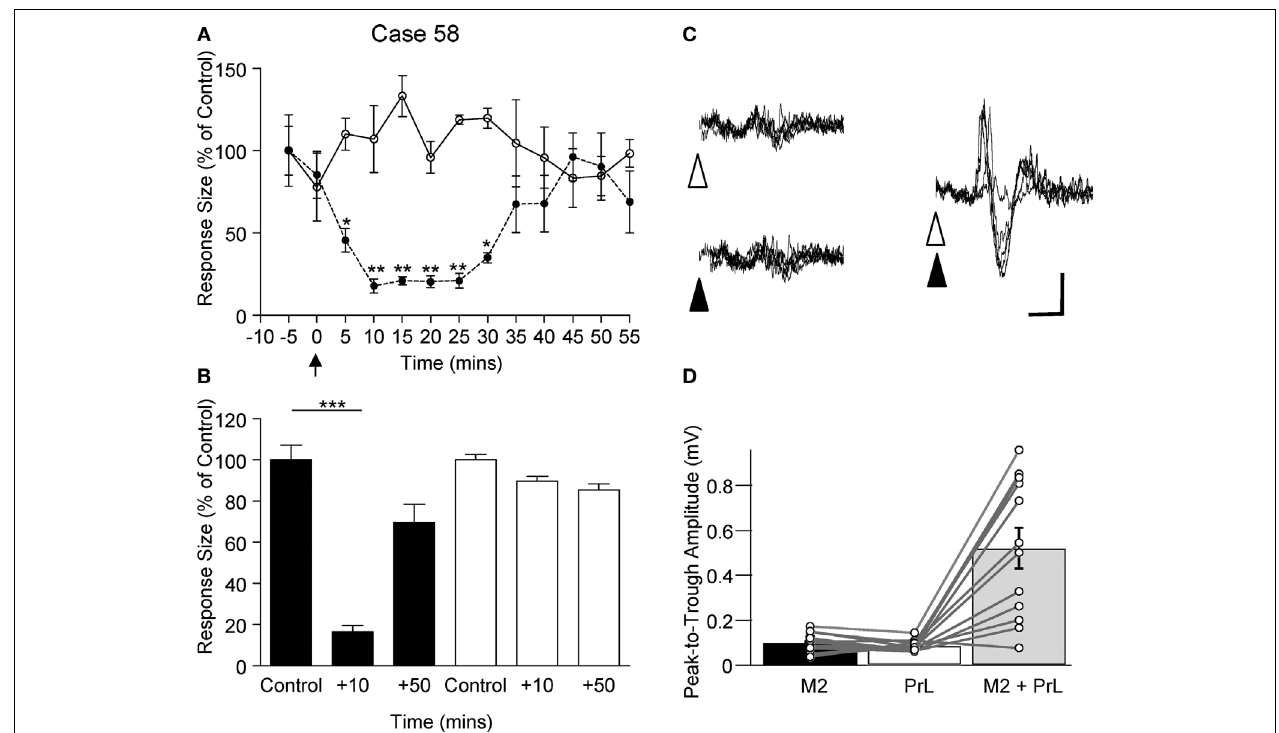
FIGURE 5 | Selective pharmacological inactivation and pathway convergence. (A) Example experiment, plotting the amplitude (expressed as a percentage of control) of evoked climbing fi bre responses, recorded at the same lobule VII site, as a function of time before and after (arrow) topical application of local anaesthetic to M2 (lidocaine, see Materials and Methods for further details). M2 evoked responses are represented by fi lled circles; PrL evoked responses are represented by open circles. Each data point represents the mean of four responses ± s.e.m. * P < 0.05; ** P < 0.01, Repeated measures ANOVA, Dunnett’s post hoc comparison against pre-anaesthetic control. (B) Pooled data from three animals in which local anaesthetic was topically applied to M2 whilst stimulating M2 and PrL alternately. Responses recorded from vermal lobule VII at two different time points after local